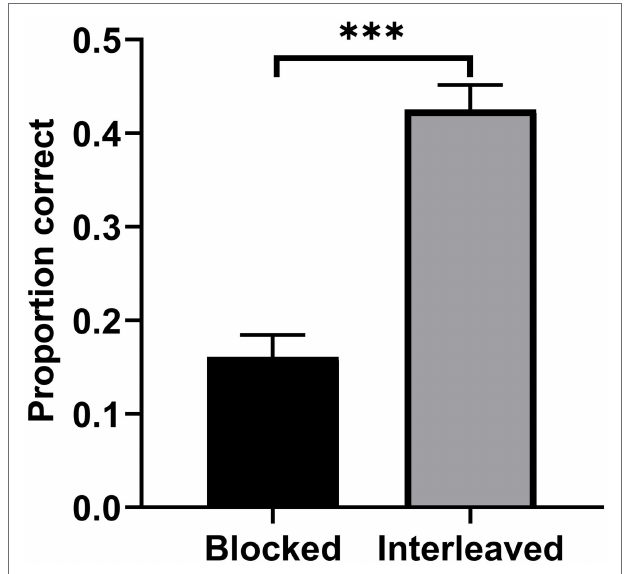
FIGURE 2 | Mean test performance as a function of study condition in Experiment 1. Error bars represent SEM. *** p < 0.001.